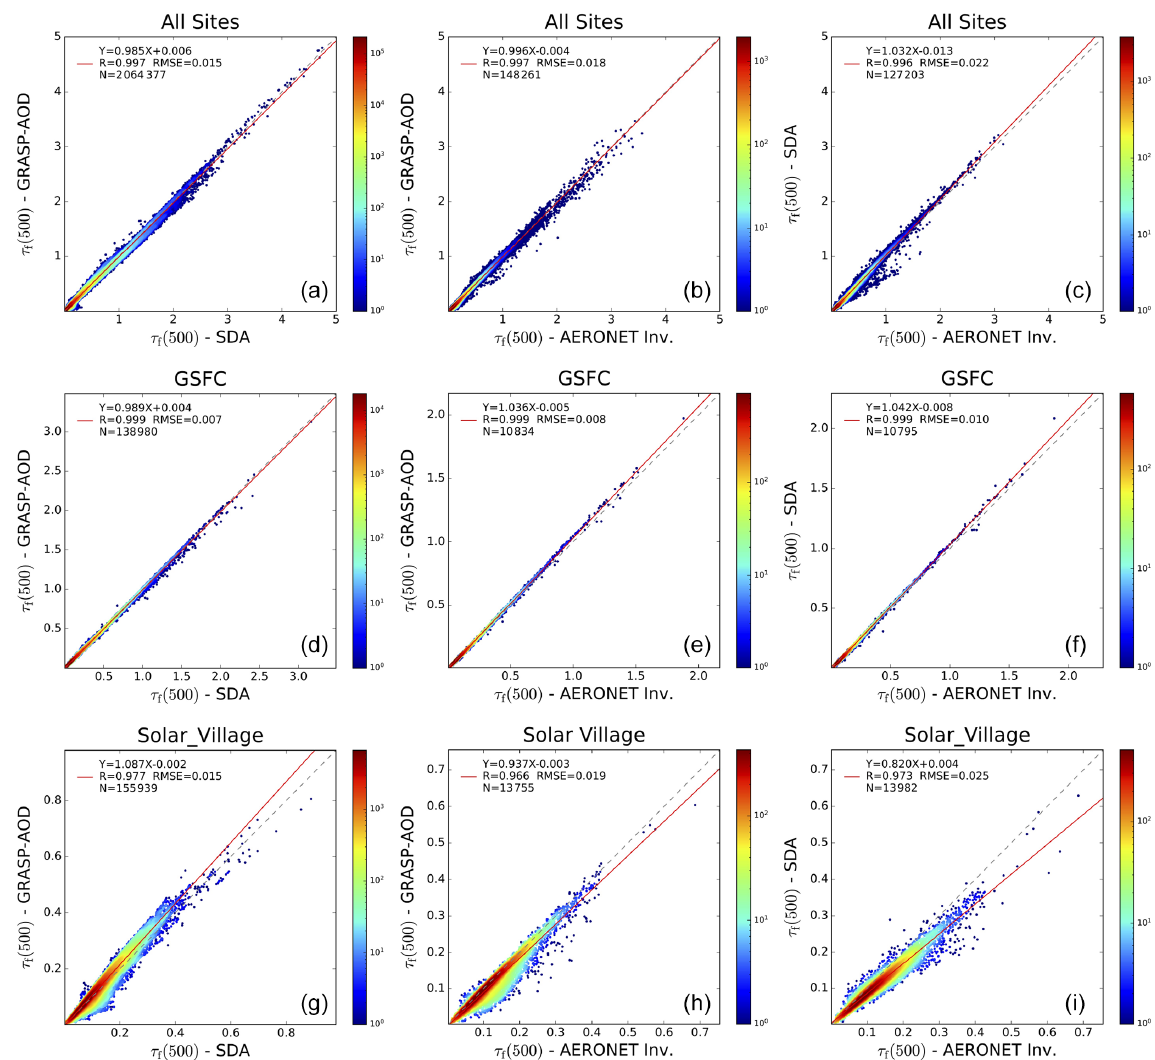
Figure 3. Comparisons of τ f ( 500 ) retrieved from the GRASP-AOD, SDA and AERONET: all sites (a) – (c) , GSFC site (d) – (f) and Solar Village site (g) – (i) . From left to right the comparisons are made between the SDA and GRASP-AOD, AERONET aerosol retrieval algorithm and GRASP-AOD, and AERONET aerosol retrieval algorithm and SDA. Color bars represent data density in a 0 . 01 × 0 . 01 grid. A logarithmic scale has been chosen given the strong data density at low